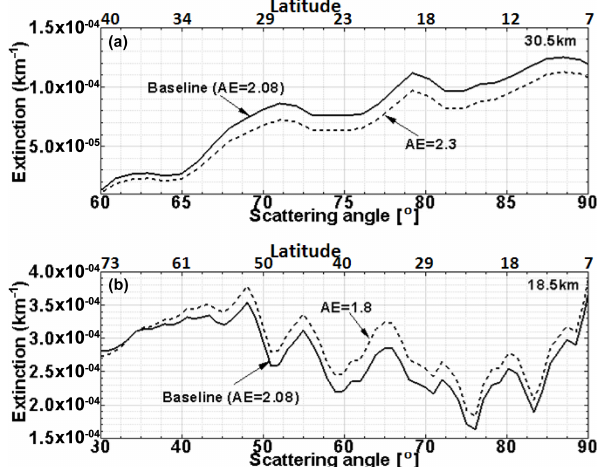
Figure 9. LP-retrieved extinction values from the baseline particle size distribution (solid line) and from the same with the Ångström exponent (AE) adjusted by ± 10% (dashed line) for an altitude of 30.5km (a) and 18.5km (b) as a function of scattering angle (bot- tom x axis) and latitude (top x axis) using OMPS/LP measurements for a single orbit on 12 September 2016. While extinction values at 30.5km with an AE of 2.3 are lower than the baseline, extinction values at 18.5km with an AE of 1.8 are higher than the baseline.